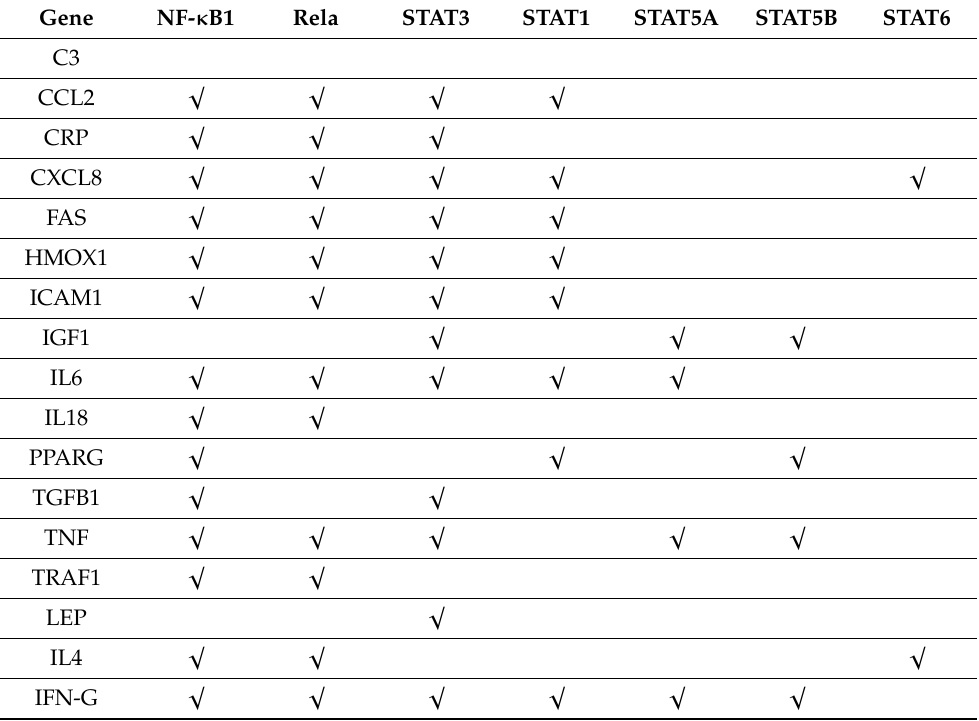
Table 1. Transcription factors that regulate the majority of the 17 genes identified by text mining. Each of the 17 genes was searched with the TRRUST version 2 (https: // www.grnpedia.org / trrust / ), TfactS (http: // www.tfacts.org / ) and Regulatory Circuits database (http: // regulatorycircuits.org / ). A total of 140 transcription factors were identified and each transcription factor was associated with at least one of the 17 genes (Supplementary Table S3). The transcription factors linked to most of the 17 genes as determined by direct evidence are